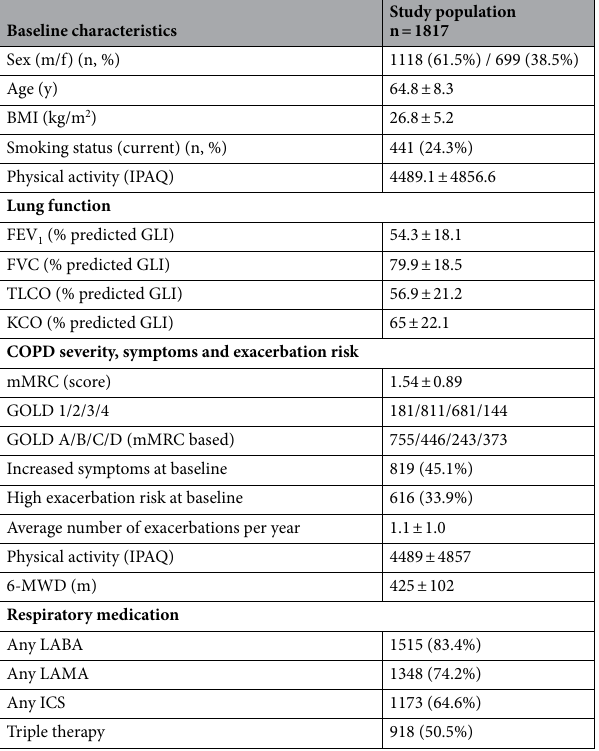
Table 1. Characteristics of the study population upon inclusion (visit 1). Data are given as mean values ± standard deviation or numbers (percentages). FEV 1 = forced expiratory volume in 1 s; FVC = functional vital capacity; TLCO = diffusing capacity for carbon monoxide (transfer factor); KCO = CO transfer coefficient; mMRC = modified Medical Research Council; IPAQ = International Physical Activity Questionnaire; LABA = long-acting beta2-agonists; LAMA = long-acting muscarinic antagonists; ICS = inhaled corticosteroids. Increased COPD symptoms refer to allocation to GOLD groups B or D and high exacerbation risk to GOLD groups C or D.